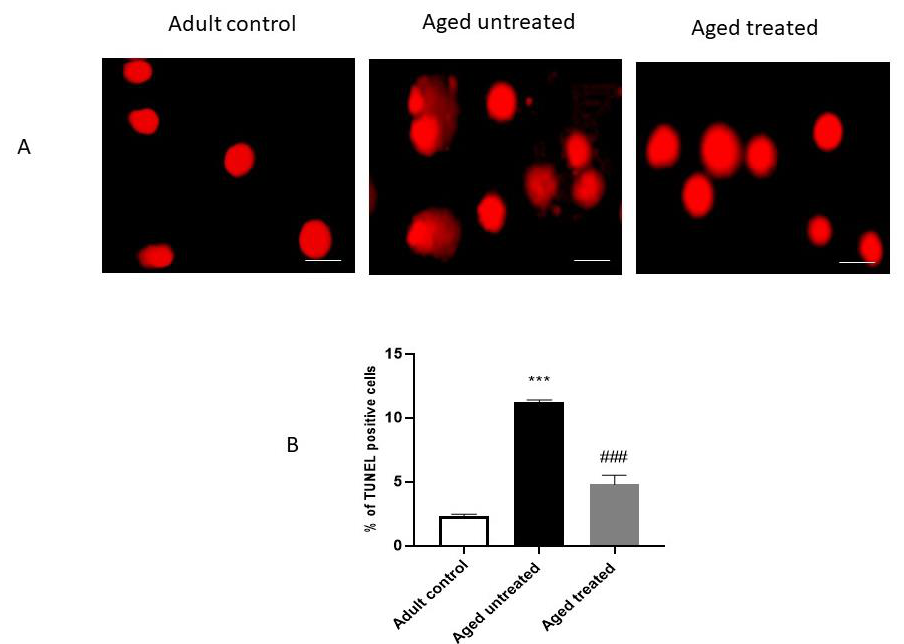
Figure 7. Effect of VK2 administration on hepatic apoptosis. ( A ) TUNEL staining in hepatic sections from different experimental groups. Scale bar (50 nm). ( B ) Percentage of TUNEL-positive cells. Values are expressed as the mean ± SE, n = 4–6. *** p < 0.001 compared to the Adult control group. ### p < 0.001 compared to the Aged untreated